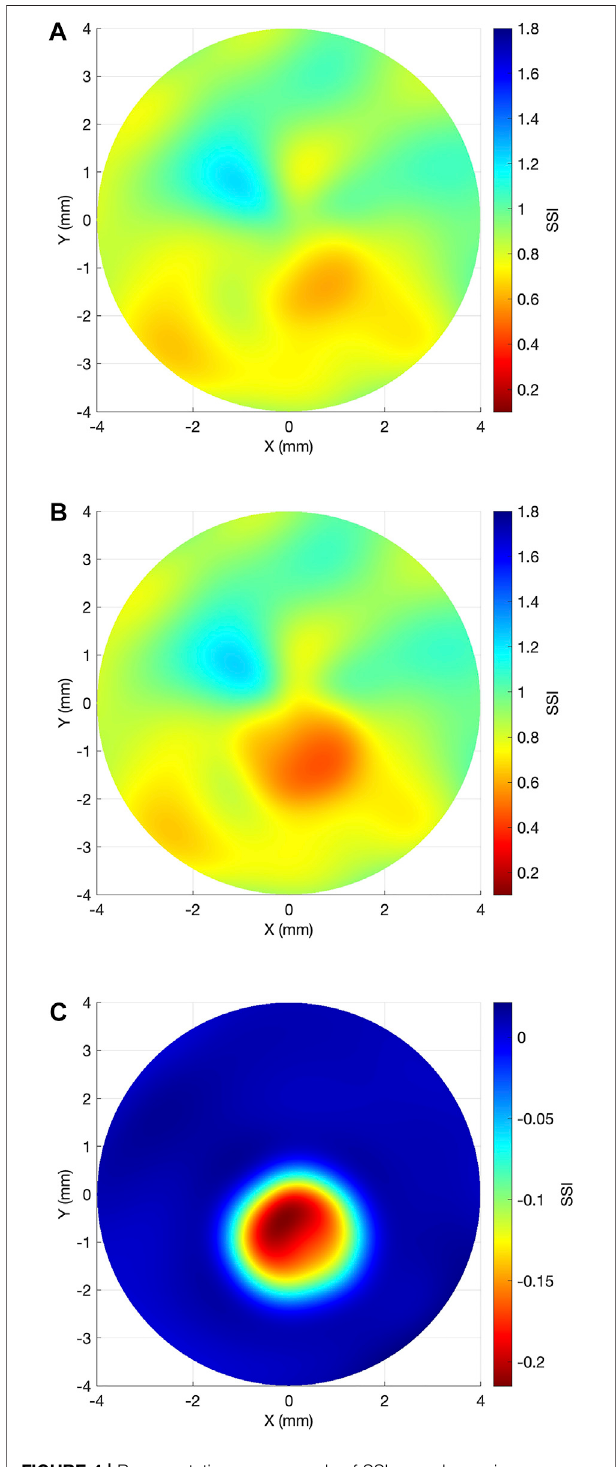
FIGURE 4 | Representative case example of SSI map change in keratoconusprogression. (A) BaselineSSImap. (B) SSImapafter25 months. (C) Differential SSI